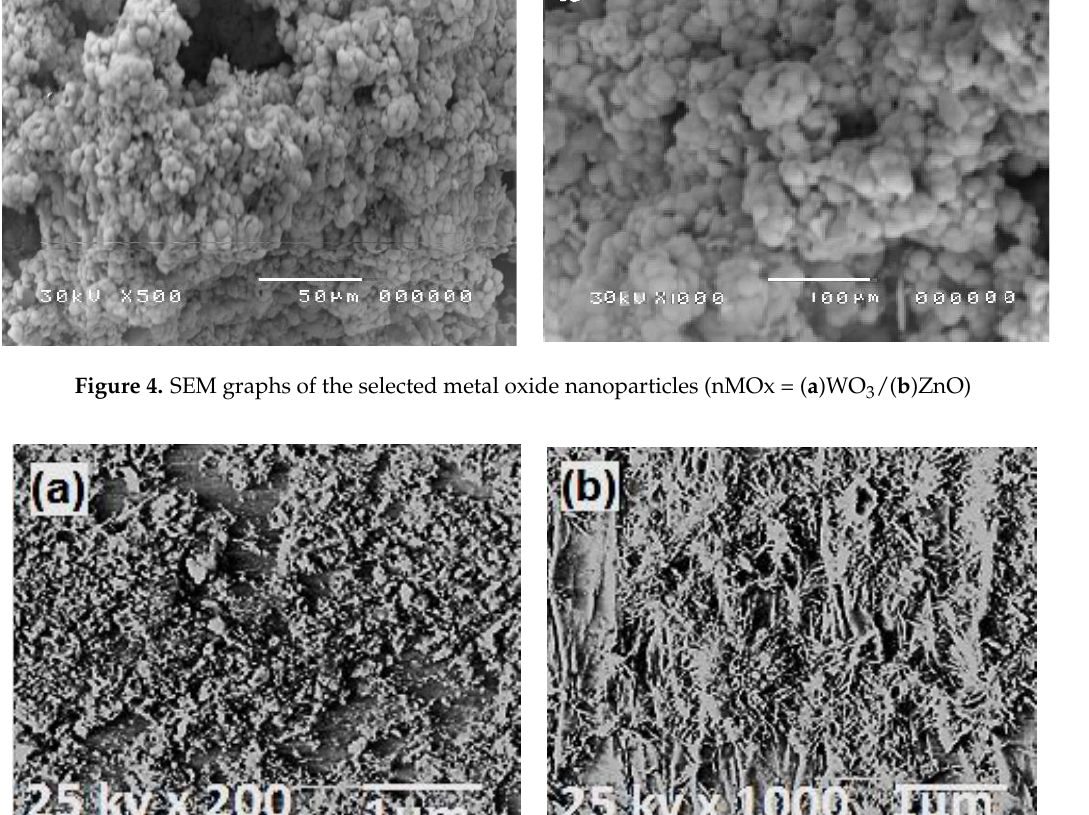
Figure 5. SEM graphs of ( a ) PES-WO 3 and ( b ) PES-ZnO nanocomposites.